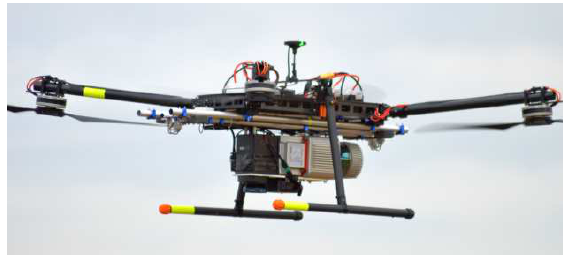
Figure 3: AeroSpector with Camera and Lidar combina- tion